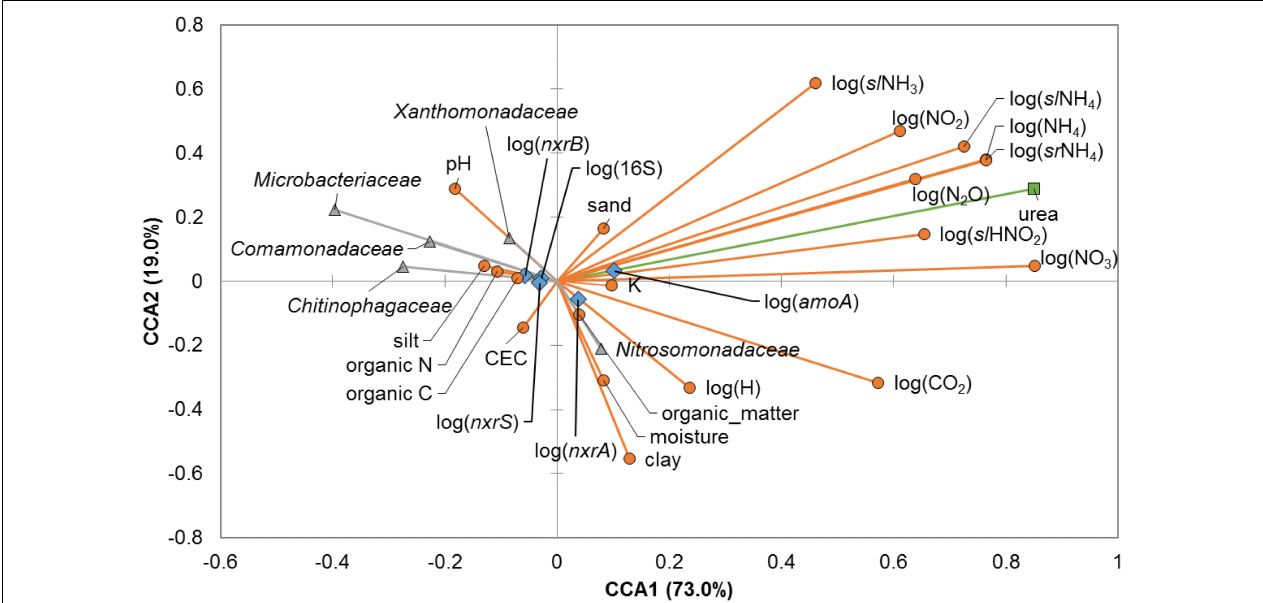
FIGURE 3 | Canonical correspondence analysis (CCA) relating bacterial families, edaphic and physicochemical parameters, and abundances of nitrification genes at 21 days post-treatment. Bacterial families presented are those in which OTUs determined to differ significantly due to nitrogen treatment by LEfSe analysis were classified. Relative abundances of all members of the families were used for CCA. Edaphic parameters and N-chemical analytes are shown as orange circles, abundances of bacterial families are shown as gray triangles, urea amendment is shown as a green square, and nitrification genes are shown as blue diamonds.